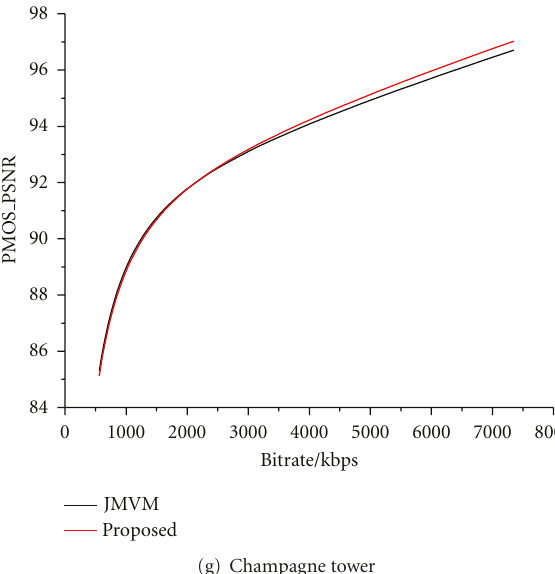
Figure 16: Rate-distortion performances comparisons between the proposed MVC and JMVM (distortions are measured with PMOS